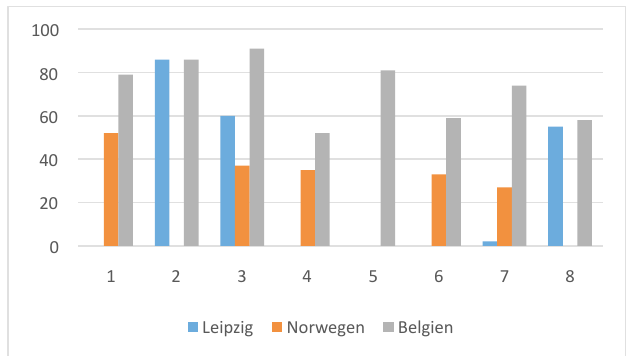
Fig. 2: Distribution of individual values in the thujon containing accessions Figure 2: Distribution of individual values in the thujon containing accessions (GC area %) 138 (GC area %) Among the thujone chemotypes, in the oils of accessions “Leipzig” and “Belgien” β-thujone content was much higher than that of the a isomer. In these spectra β-thujone varied from 50% to 89% of total oil while α-thujone was observed in less than 2% of total area percentage of the investigated oils. The majority of the references on wormwood indicate similar tendency. B lagojević et al. (2006) investigated Serbian natural populations and brought about 63.4% concentration for β-thujone with 0.4% for